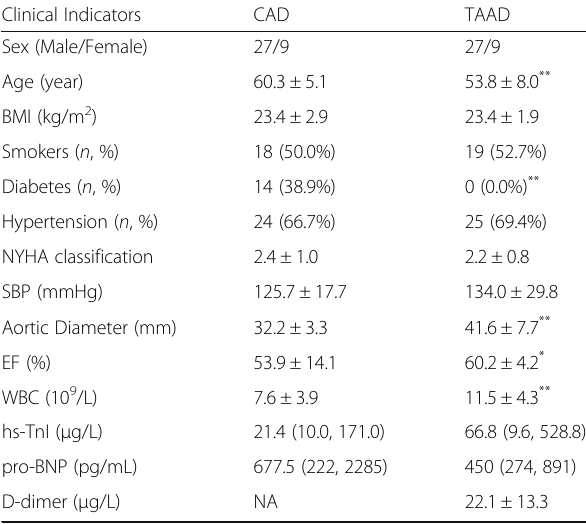
Table 1 The clinic information of